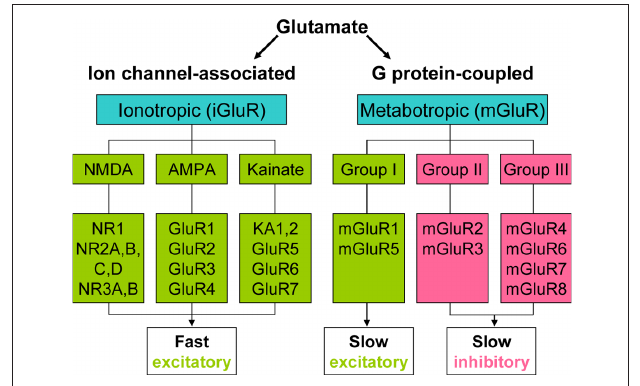
Figure 1 | Classification of glutamate receptors.